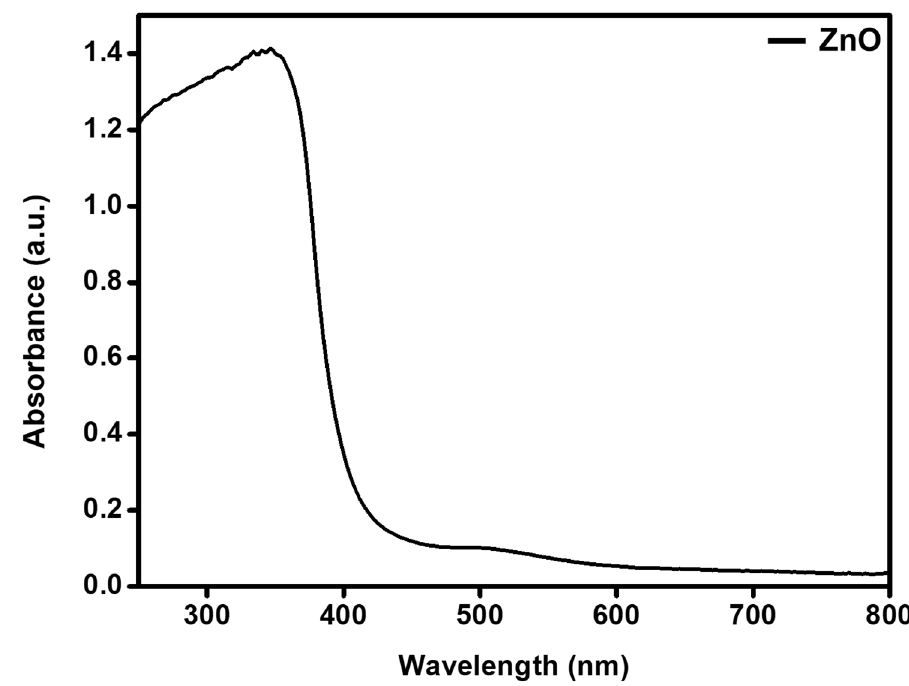
Figure 1. UV–Vis spectra of the prepared ZnO-GS nanoparticles. Figure 2 reveals the diffractogram obtained for the ZnO-GS nanoparticles, which were obtained through the combustion method using cow dung as fuel. The diffracted